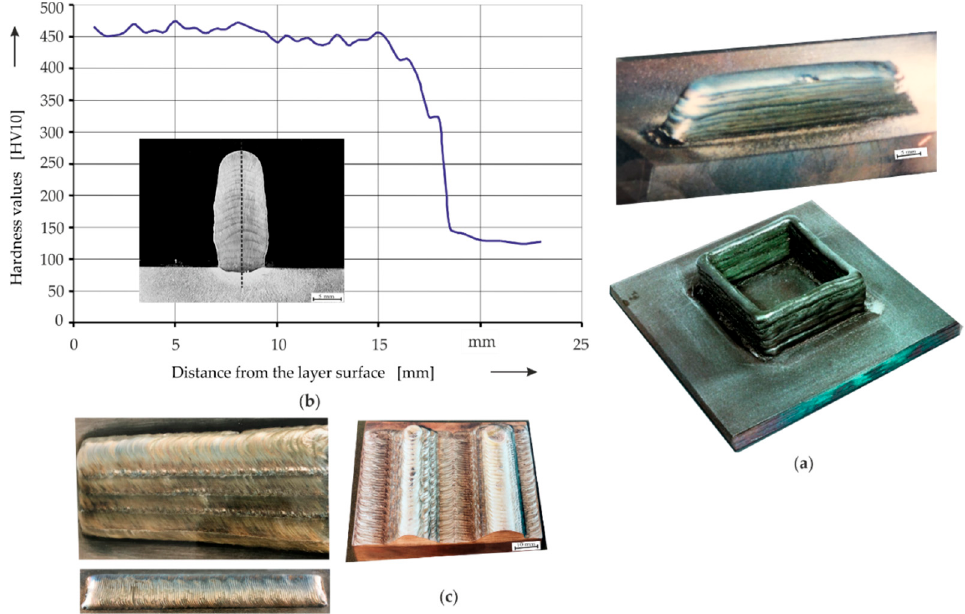
Figure 1. Three-dimensional plasma metal deposition (3DPMD) samples: ( a ) Linear PMD contours, ( b ) hardness profiles for linear PMD and ( c ) weaving PMD contours.